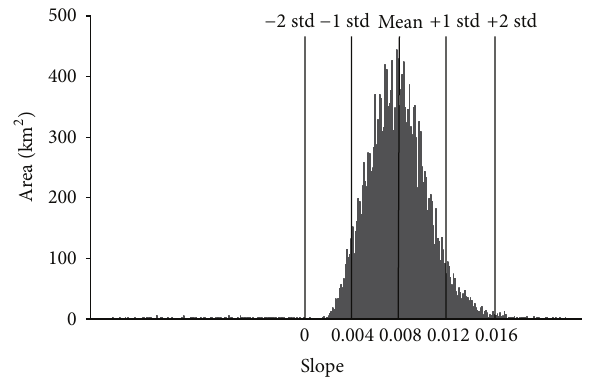
Figure 4: The statistical distribution of the significant slope. (The std stands for standard deviation.)